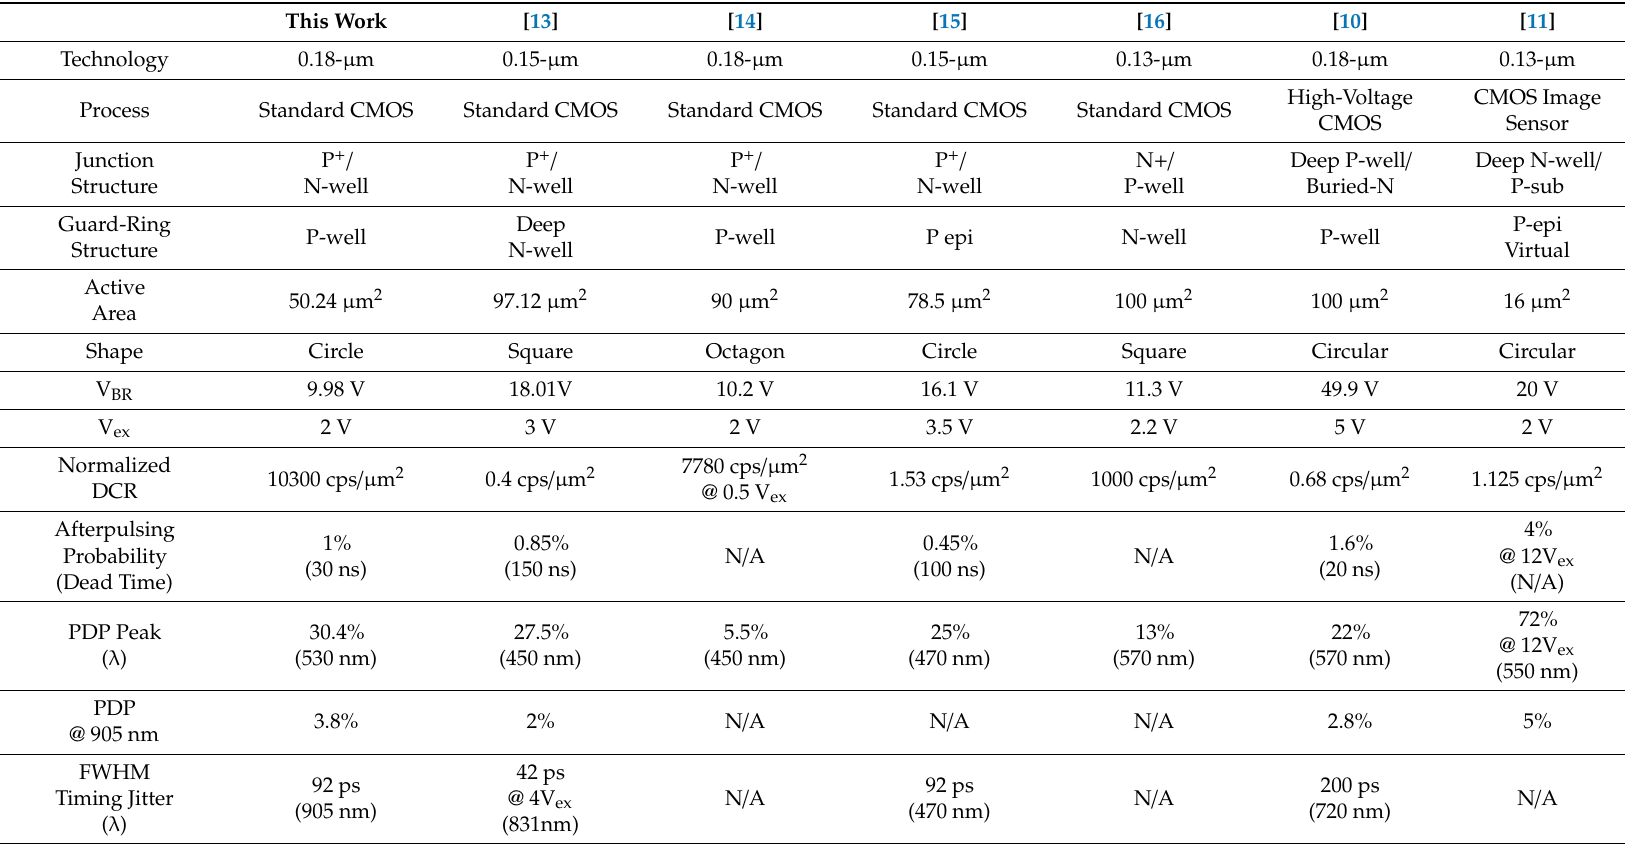
Table 1. Performance summary and